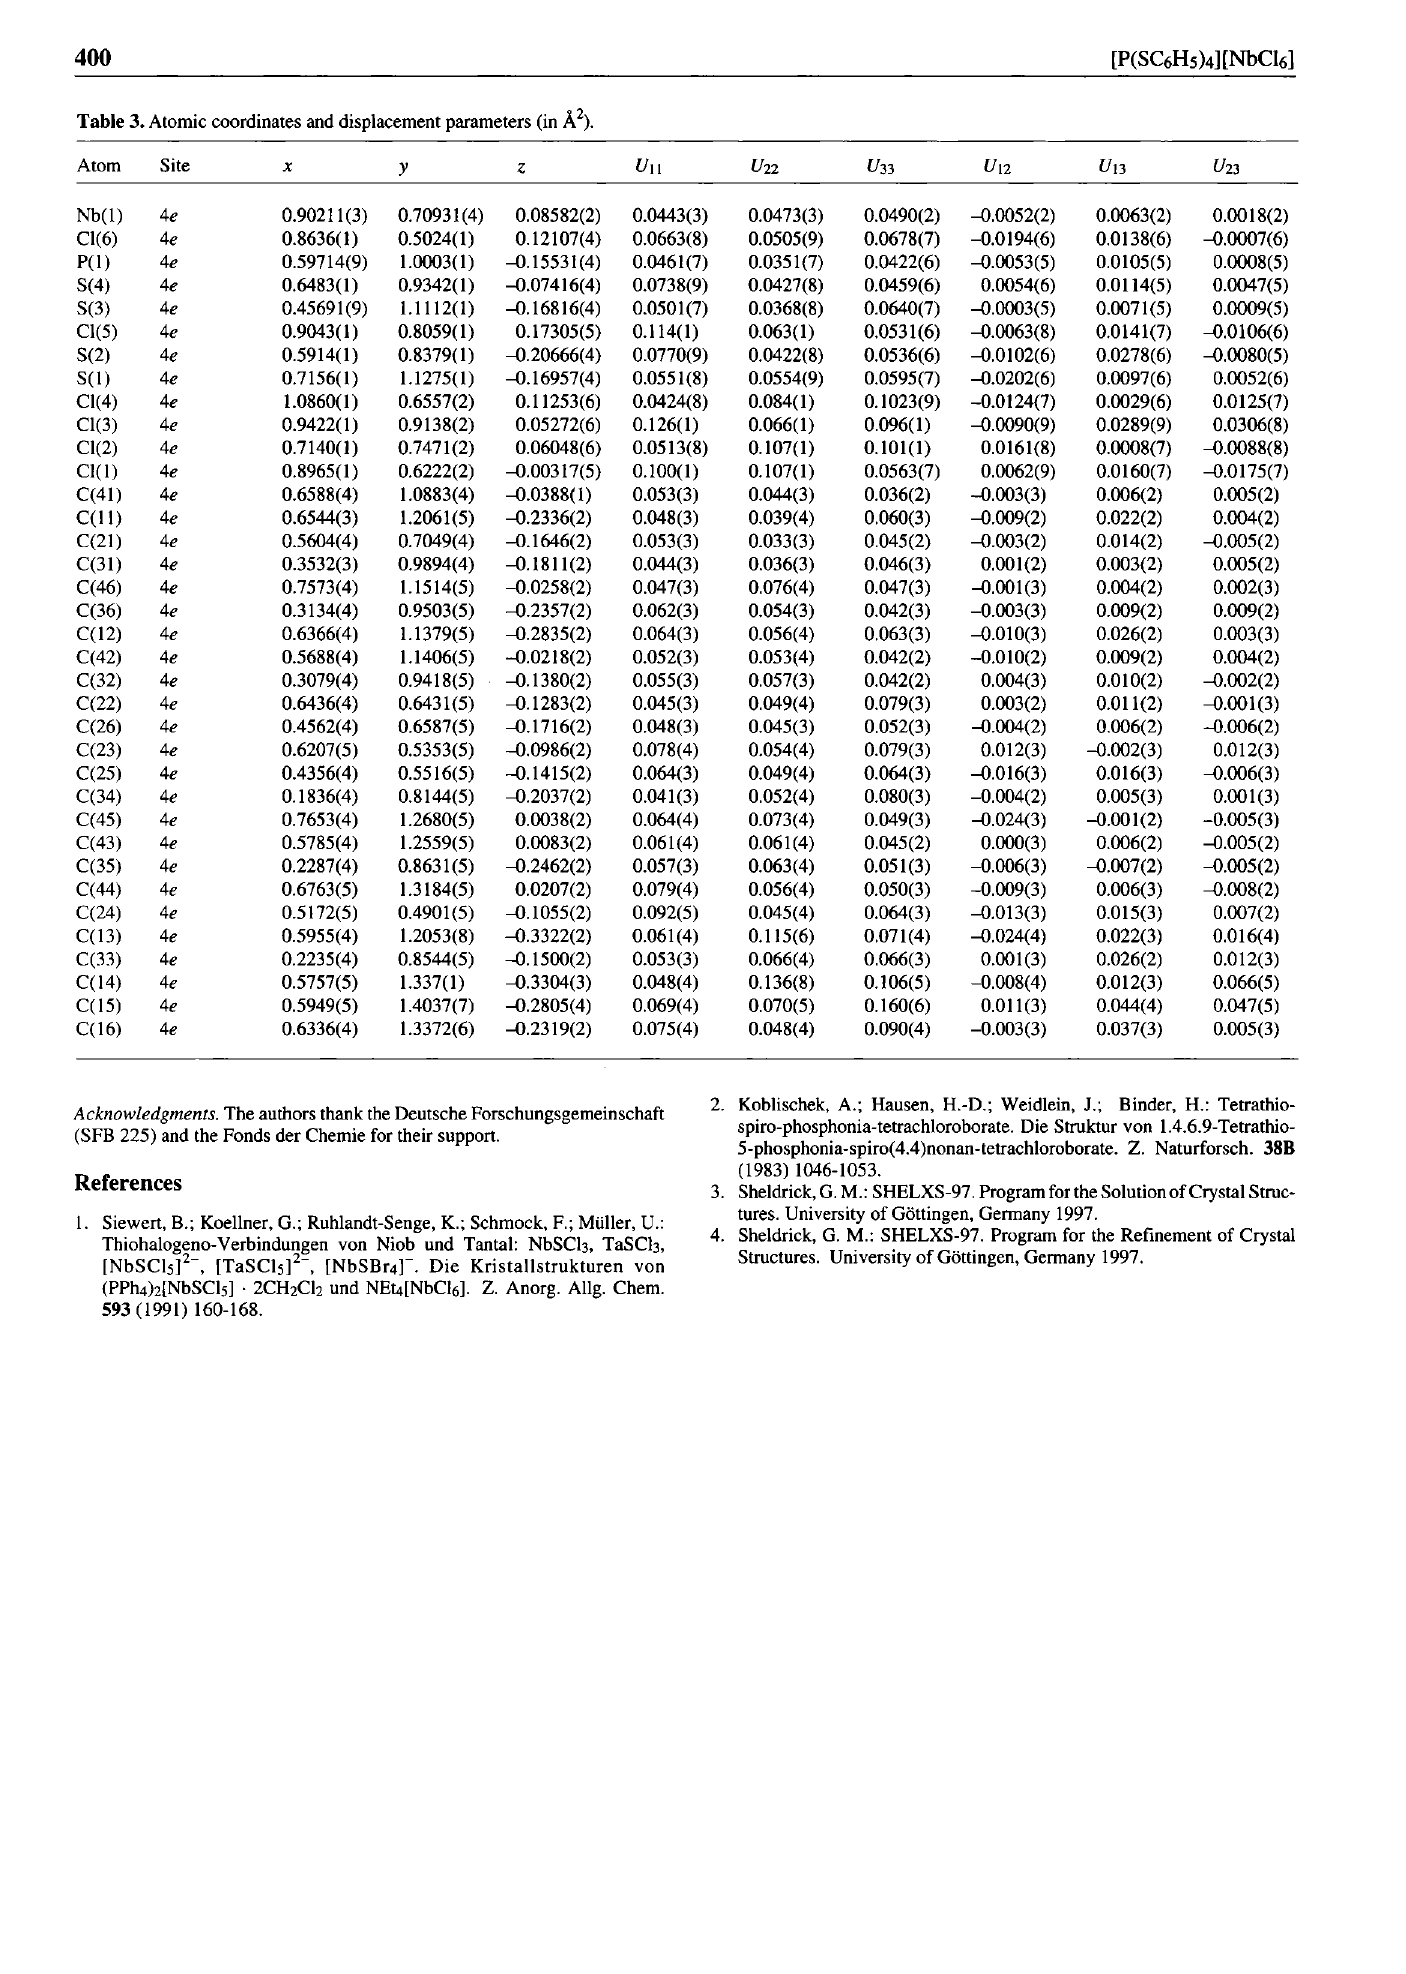
Table 3. Atomic coordinates and displacement parameters (in Â 2